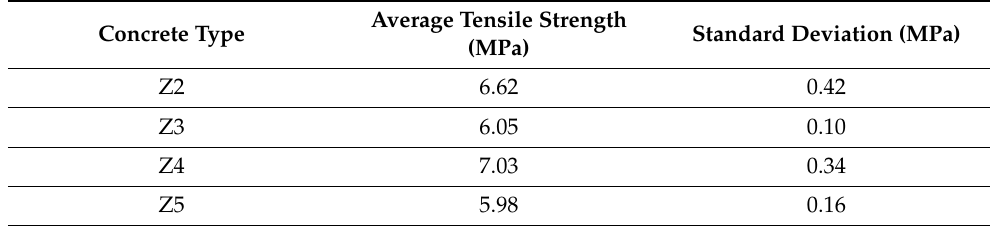
Table 11. Results of the tensile strength test at bending of the Z1 concrete beam depending on the reinforcing fibers used in the block